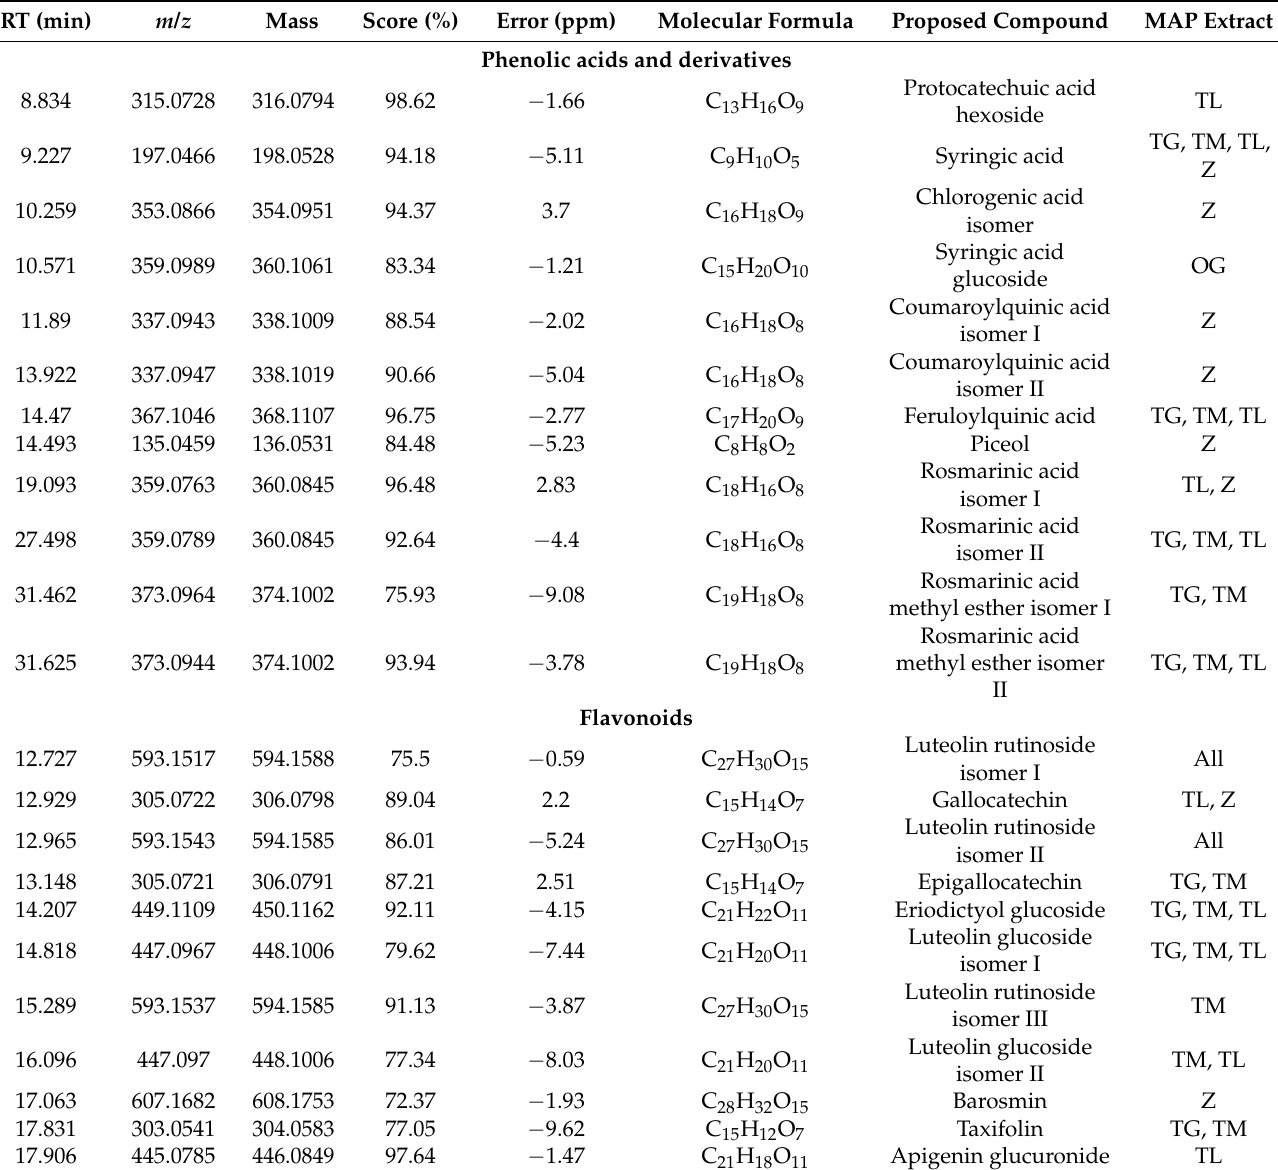
Table 1. Chemical characterization of aromatic plant